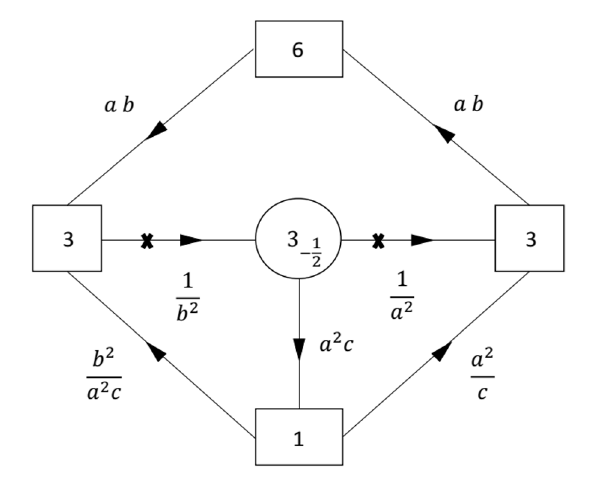
Figure 14 . The tube we get by gluing the tube in figure 13(a) with the one in figure 13(b). As usual, we have denoted the charges under the non-R symmetries using fugacities.